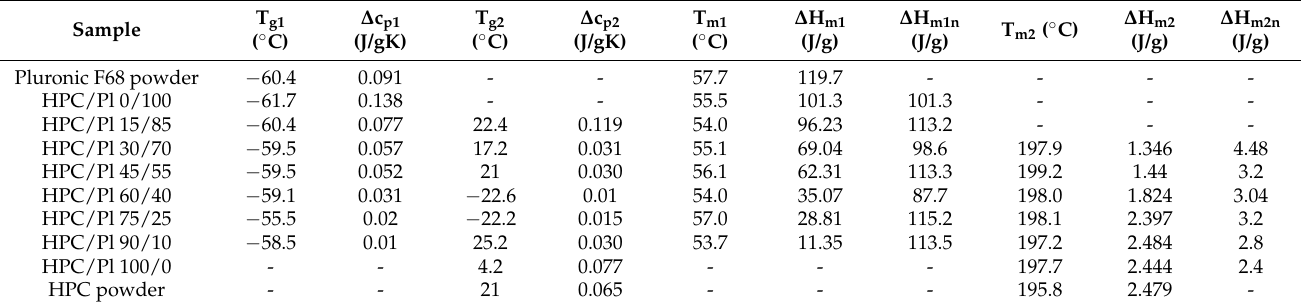
T g1 and ∆ c p1 —glass transition temperature and change in heat capacity corresponding to Pluronic F68 component; T g2 and ∆ c p2 —glass transition temperature and change in heat capacity corresponding HPC component; T m1 , ∆ H ∆ H m1 and m1n —melting temperature, melting enthalpy and melting enthalpy normalized to Pluronic content corresponding to Pluronic component; T m2 , ∆ H m2 and ∆ H m2n —melting temperature, melting enthalpy